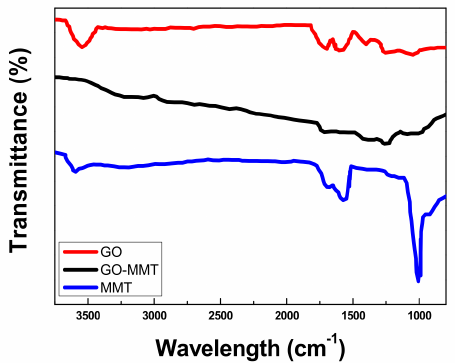
Figure 3. FTIR patterns of GO, MMT, and GO-MMT.